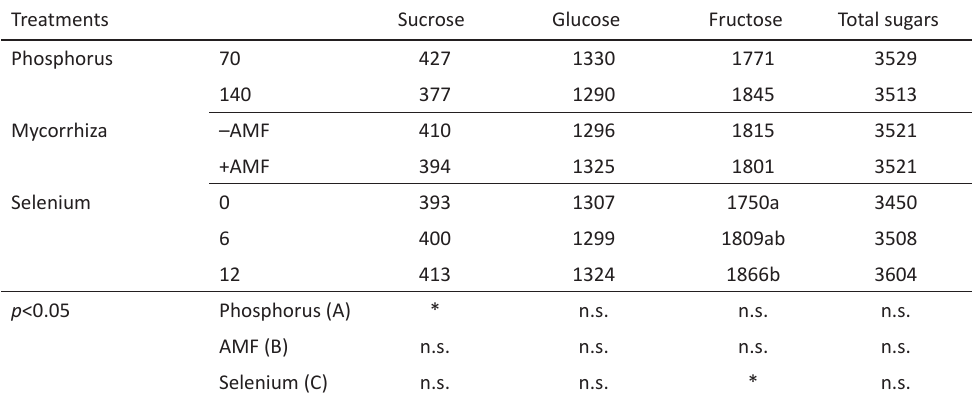
Table 5. Effect of mycorrhiza on content of sugars (mg 100 g -1 f.m.) in lettuce grown on medium with different levels of phosphorus and selenium (mg dm -3